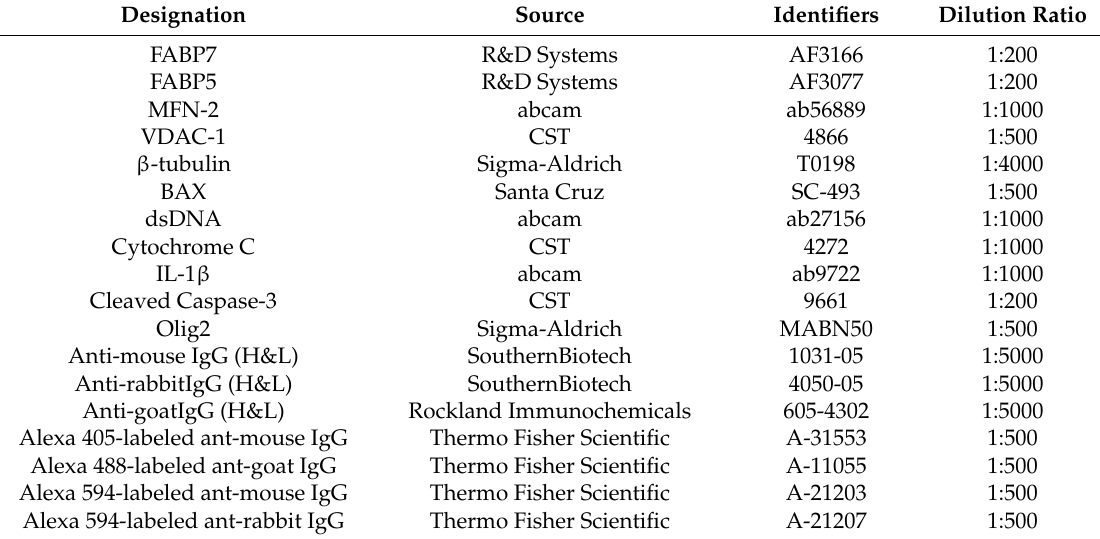
Table 1. Key resources of